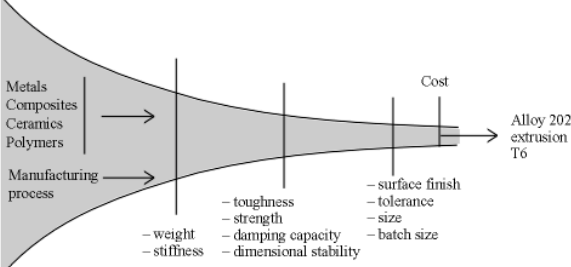
Figure 2. The funnel-like shape of a typical MS procedure and some decision steps along the way. Some constraints related to perfomance and to properties are shown. The decision-sequence along the the horizontal axis is only demonstrative; for instance, cost could have been the first gate.